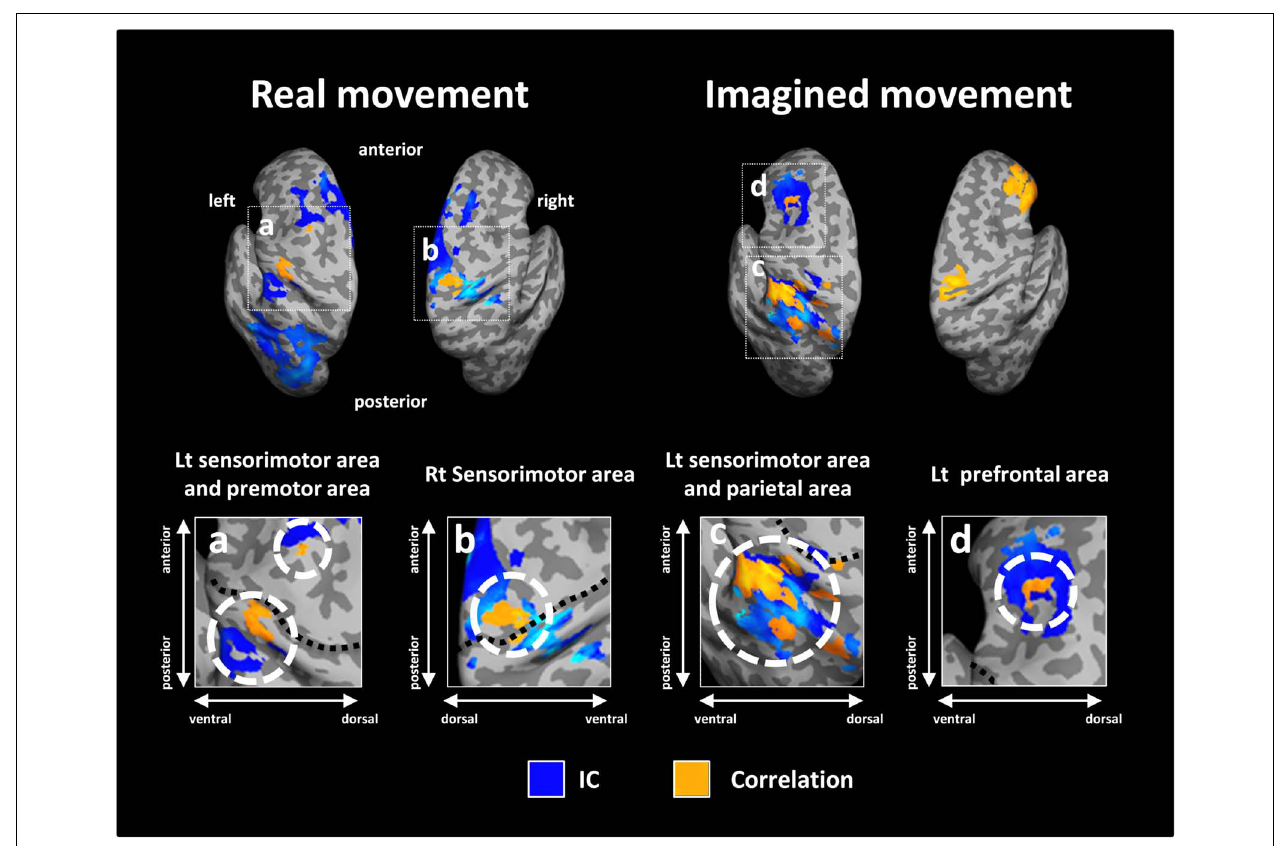
FIGURE 5 | Overlay of imaginary coherence (IC) and correlation coefficient results for real and imagined movements. Most of the significant correlations (orange) were located in or around brain regions (white dotted circles) with significant IC (blue). For imagined movements, there was no co-localization between significant correlations and